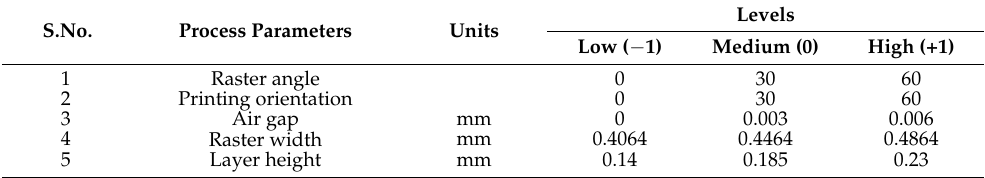
Table 3. Process parameters and their range for experiments.